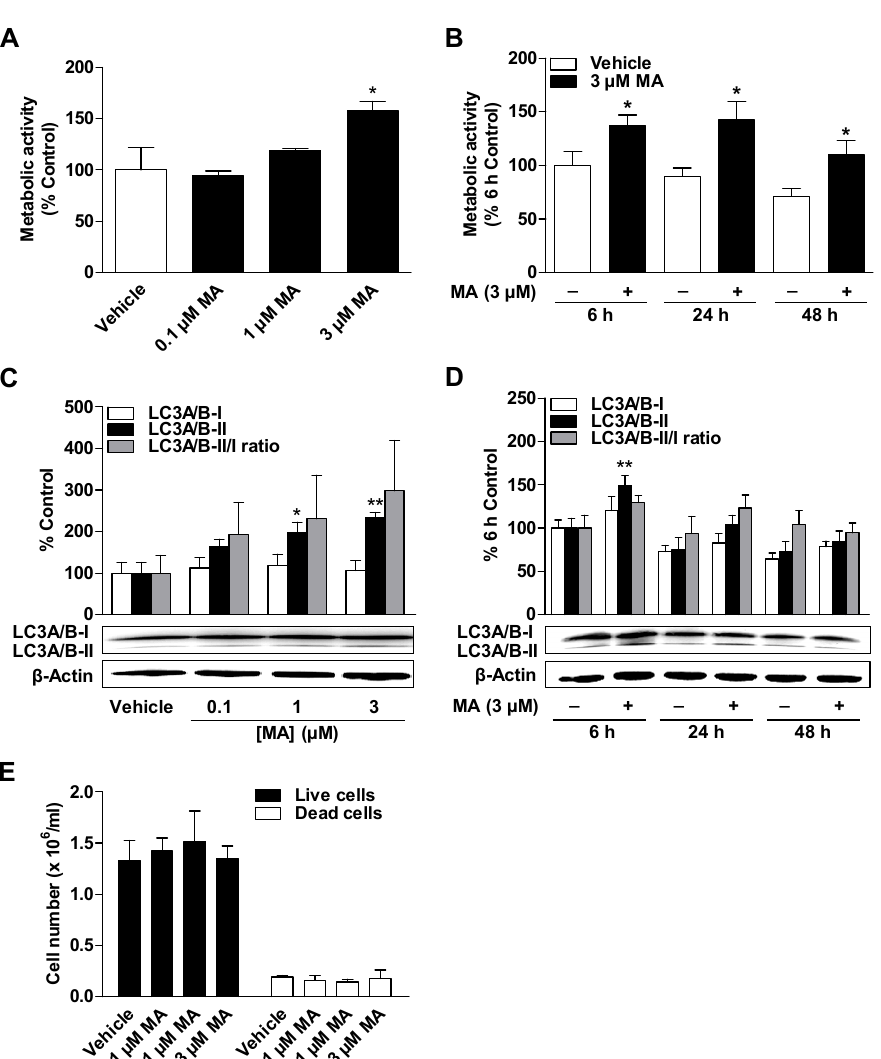
Figure 3. Concentration- and time-dependent effect of MA on metabolic activity, autophagy, and cell count of ADMSCs. The cells were incubated with the indicated concentration of MA or vehicle for 24 h ( A , C , E ) or with 3 µM MA or vehicle for the specified times ( B , D ). After incubation, the cells were analyzed for their metabolic activity by WST-1 assay ( A , B ), for their LC3A/B-I/II protein expression by Western blot analysis ( C , D ), and for their cell count ( E ) by trypan blue staining. The protein expression values were normalized to β -actin. The percentage control represents a comparison with the time-matched vehicle-treated cells ( A , C ) or the cells treated with vehicle for 6 h ( B , D ). The data represent mean values ± SEM of n = 4 ( A , C ), n = 6 ( B ), n = 8 ( D ), or n = 3 ( E ) different donors. * p < 0.05, ** p < 0.01 vs. time-matched vehicle; one-way ANOVA with Dunnett’s post hoc test ( A , C ) or Student’s t test ( B , D ).